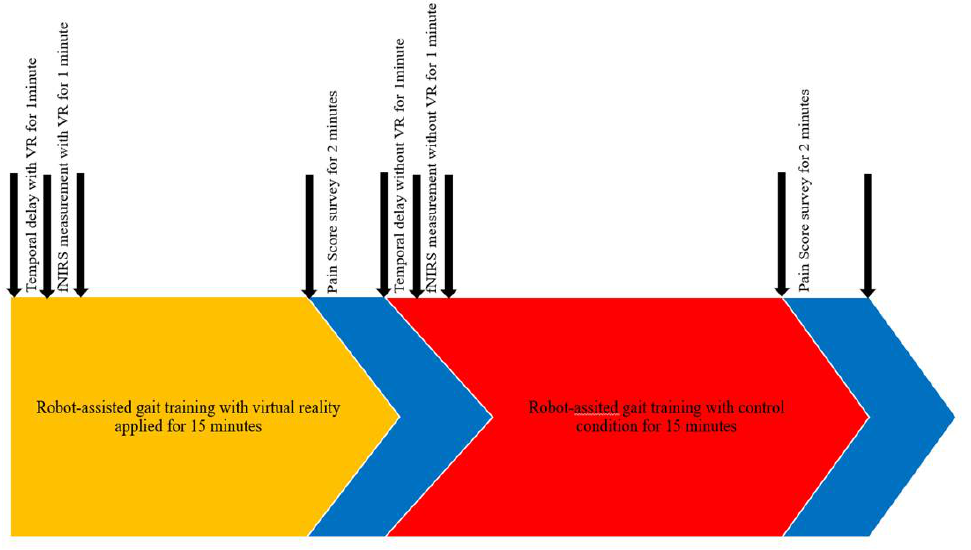
Figure 3. Block diagram of the protocol.